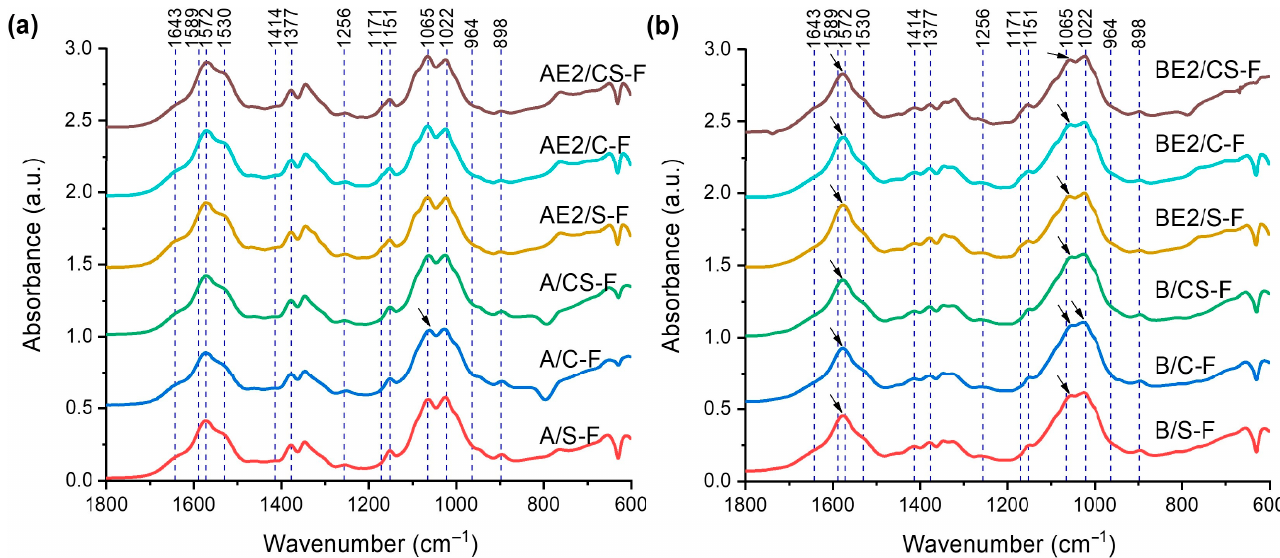
Figure 2. Figure 2. Fourier-transform infrared (FTIR) spectra for the different bionanocomposite films: ( a ) chitosan matrix; and ( b ) chitosan/carboxymethyl cellulose (CMC) matrix. The reference lines indicate characteristic bands for unprocessed CMC (1589, 1414, and 1022 cm − 1 ) [13], unprocessed chitosan (1643, 1572, 1530, 1377, 1256, 1151, 1065, 1022, and 898 cm − 1 ) [28], [C 2 mim][OAc] (1171 cm − 1 ) [29], and SPT (964 cm − 1 ) (see Figure S3). The arrows indicate shifts in peak